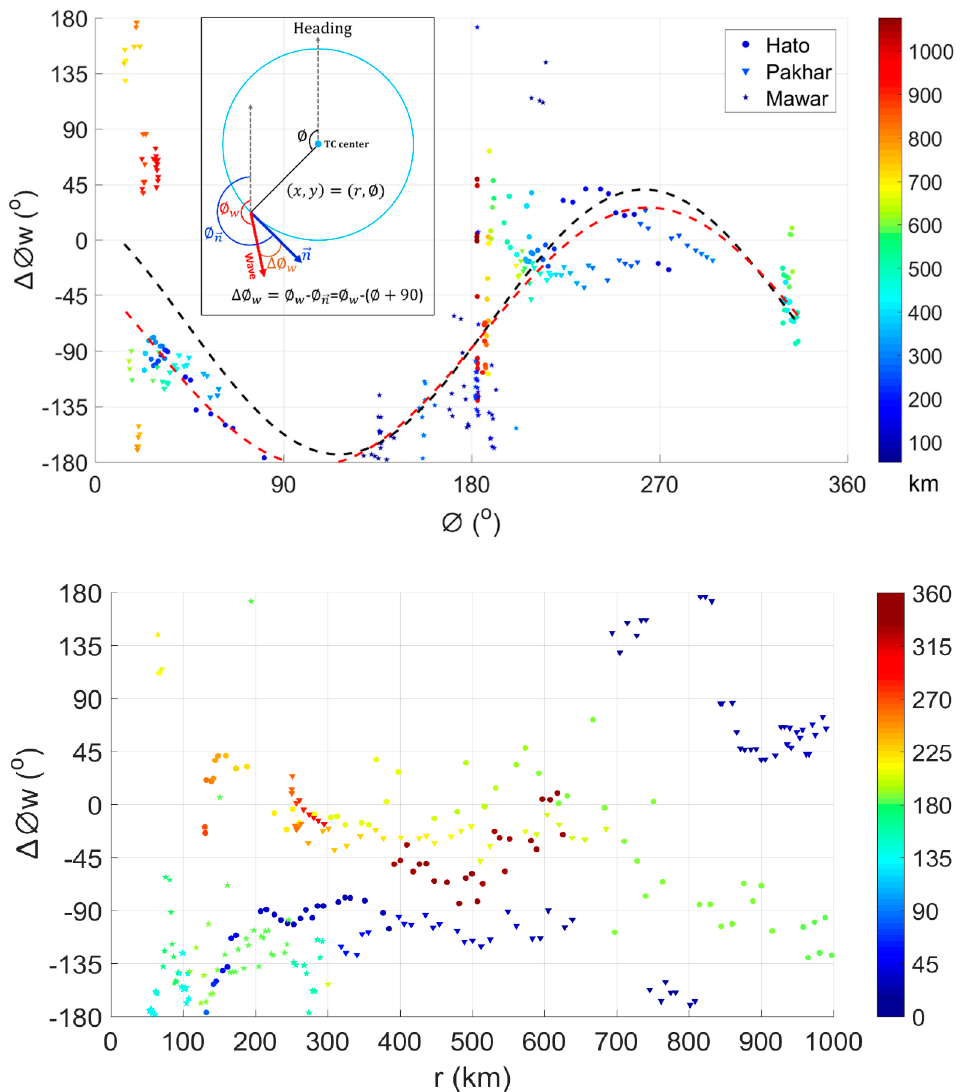
Figure 7. Dependency of the wave direction on azimuthal variation and radial distance for Hato (dot), Pakhar (triangle), and Mawar (pentagram). ∅ is the azimuth angle of the observation location; ∅ (cid:3050) represents the wave direction measured from the TC heading; ∅ (cid:3041)(cid:4652)(cid:1318) represents the angle of the location vector normal representing the ideal local wind direction; and ∆∅ (cid:3050) represents the angle of wave direction relative to the location vector normal. Negative (positive) ∆∅ (cid:3050) suggests the TC wave propagates to the right (left) side of the local wind. The black smooth dashed line is one-term-Fourier-fit curve through all the data and the red dashed line is one-term-Fourier-fit curve through the data within 700 km radial distance. The color coding represents the radial distance from the TC center (top) and azimuth angle (bottom), respectively.